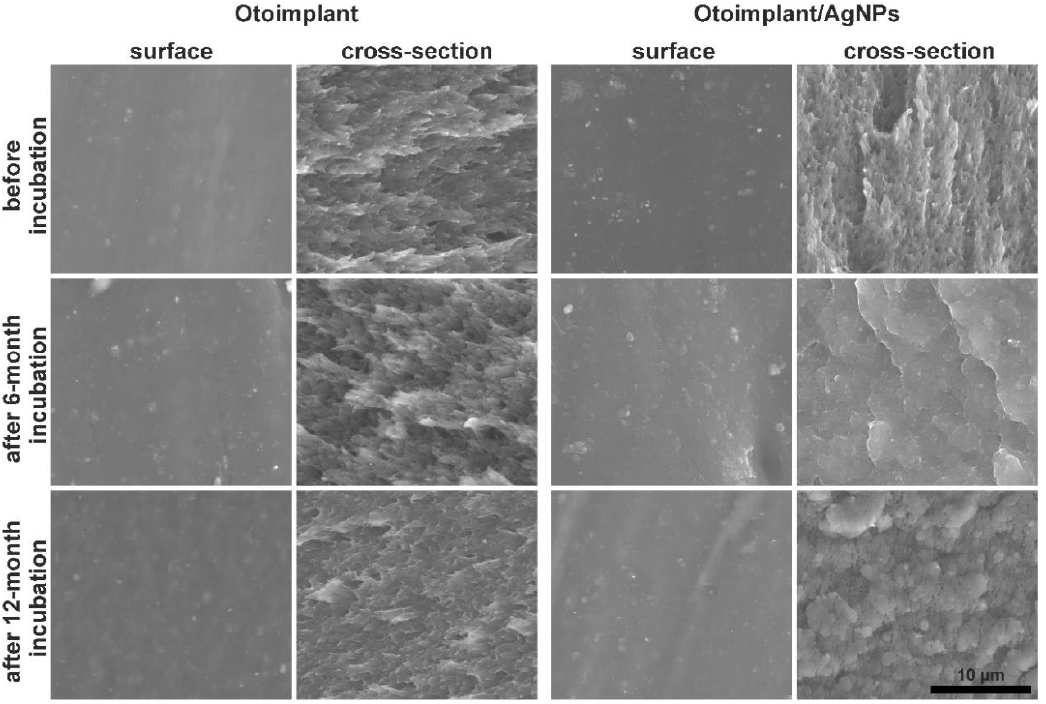
Figure 1. Scanning electron microscope (SEM) images of the surfaces and cross-sections of the Otoimplant and Otoimplant/AgNPs before and after 6- and 12-month incubation in deionized